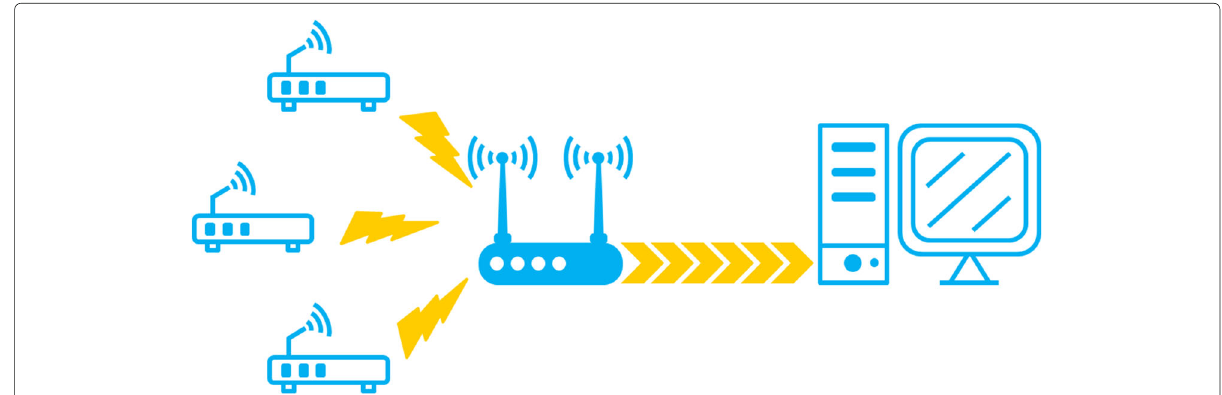
Fig. 1 Classical architecture of WiFi-based wireless sensor